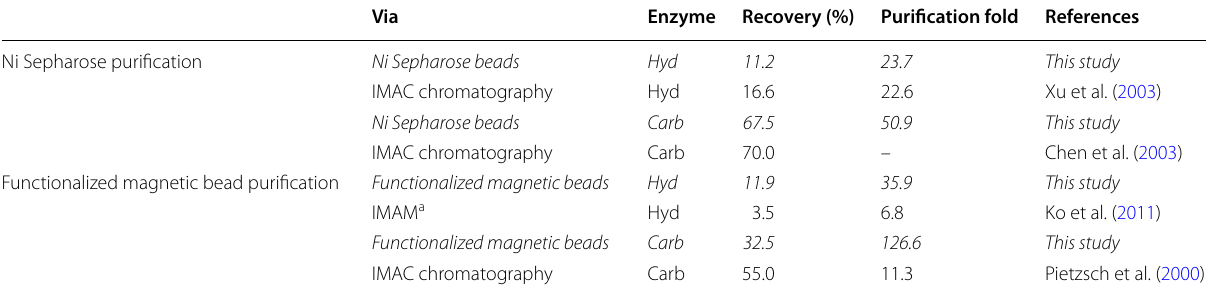
Table 4 Overview of investigated purification and immobilization methods for both enzymes and comparison to other works